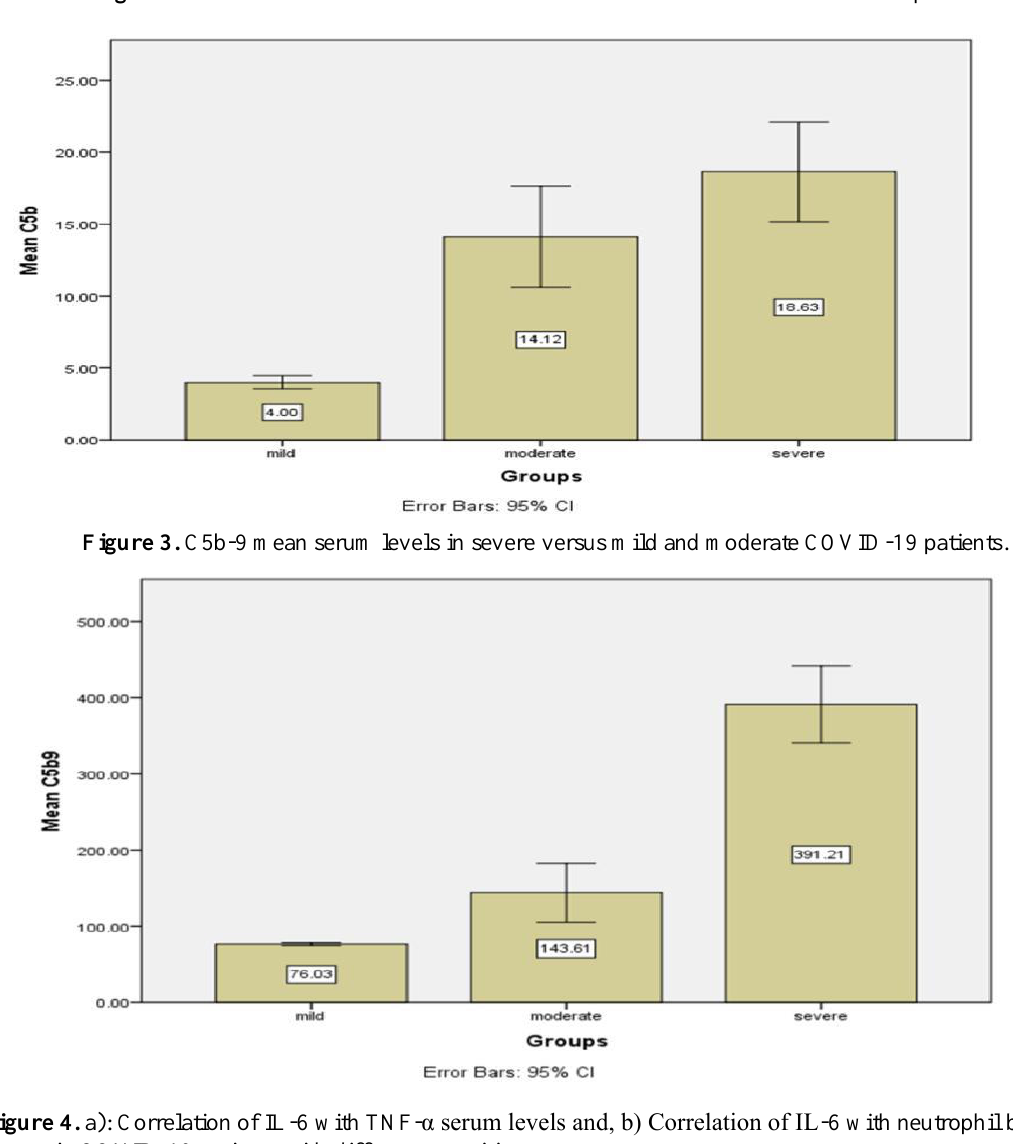
Figure 2. C5b mean serum levels in severe versus mild and moderate COVID-19 patients.